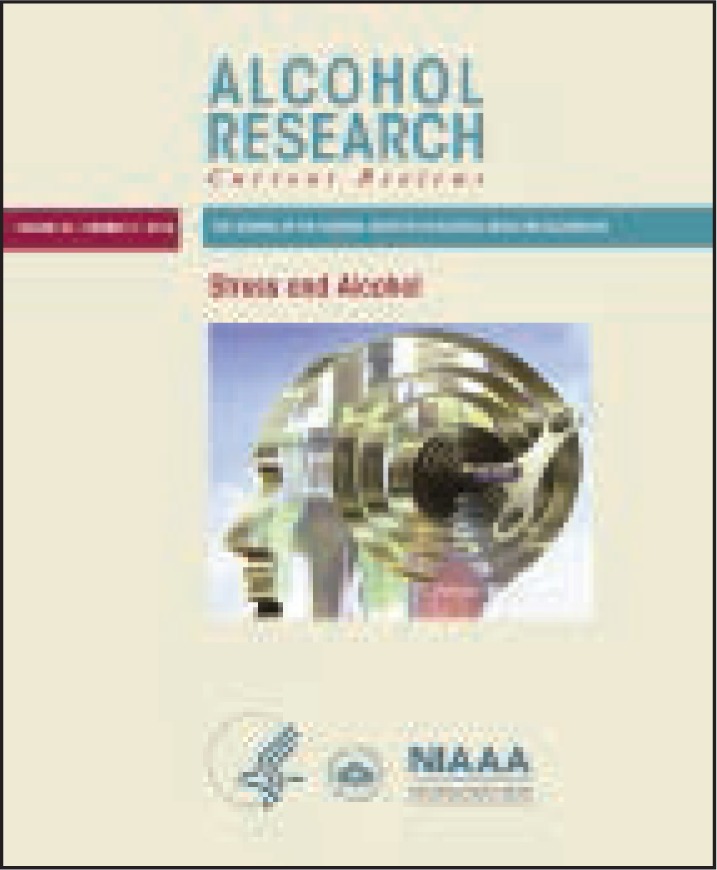
Stress and Alcohol